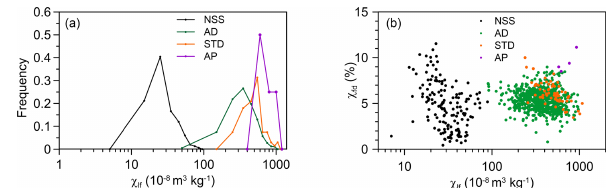
Figure 9. Frequency distributions of χ lf (a) and bivariate plots of χ lf versus χ fd (b) of NSS, STD, AD, and